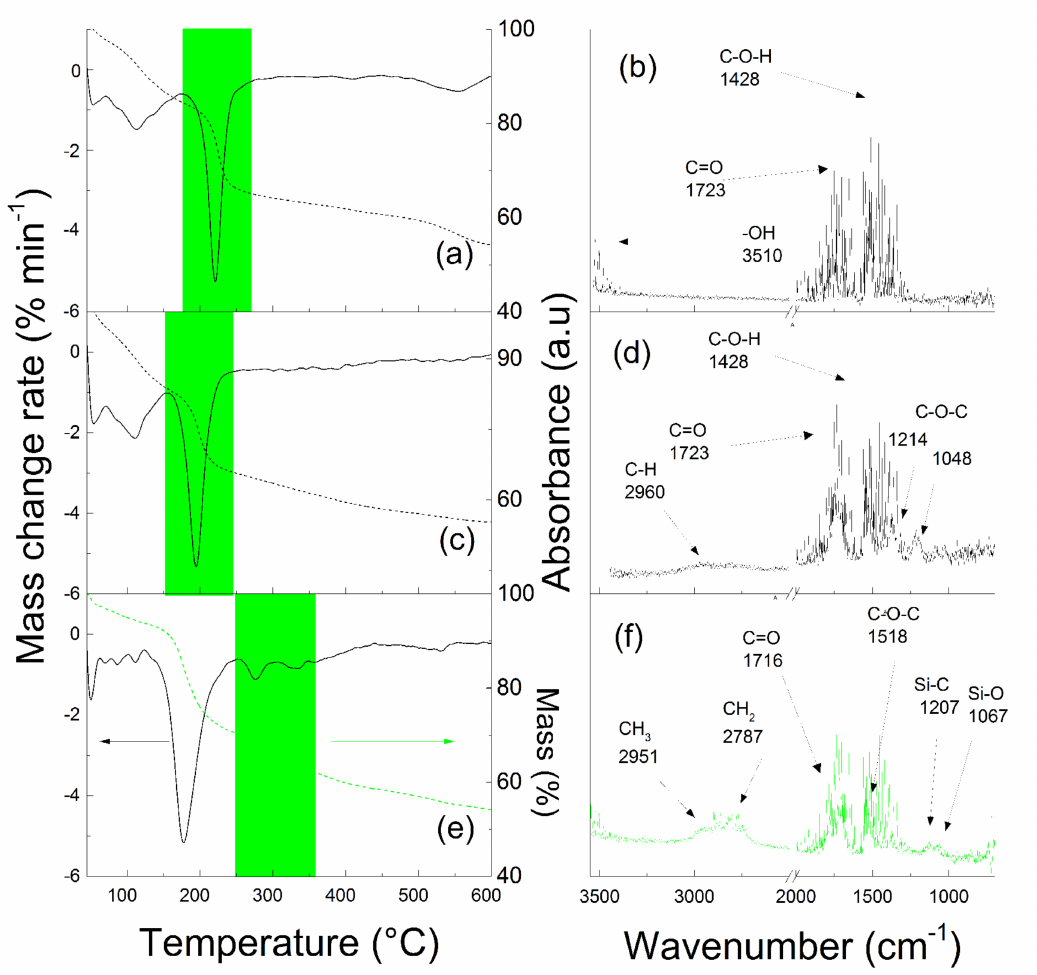
Figure 3. TGA analysis ( a , c , e ) with on-line monitoring of volatile degradation products from the green marked temperature range by the FTIR spectra ( b , d , f ) for a neat GO ( a , b ), GO-initiator and ( c , d ) and GO–PHEMATMS ( e , f )